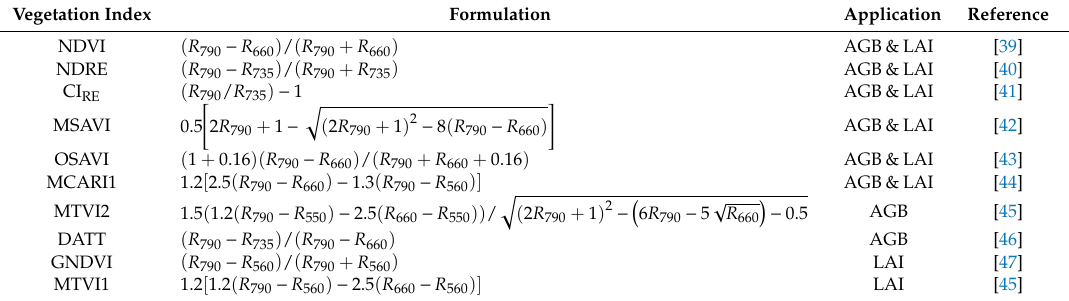
Table 3. Selected vegetation indices used for aboveground biomass and leaf area index